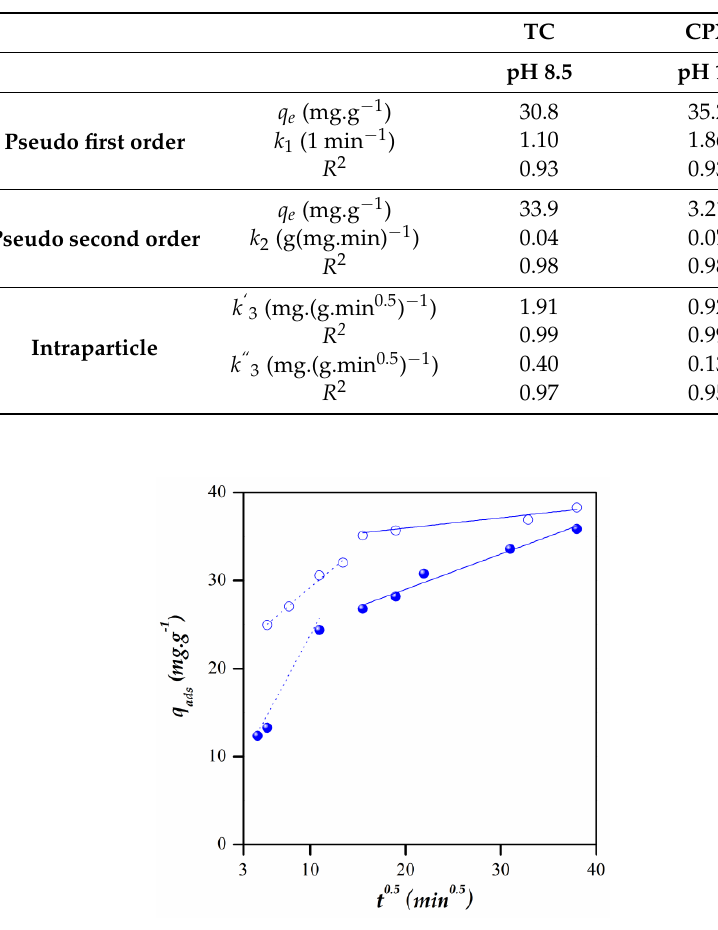
Figure 8. Intraparticle diffusion model for the adsorption of TC (●) and CPX ( O ) on Si-PILC 75. Table 3. Pseudo-first-, -second-order, and intraparticle rate parameters for TC and CPX on Si-PILC 75.